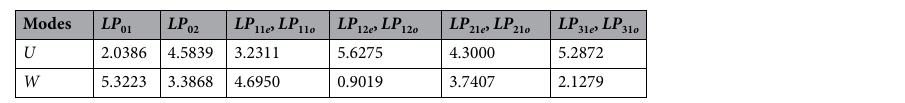
Table 1. The values of U and W for the LP modes that the communication fiber used for the demonstration can